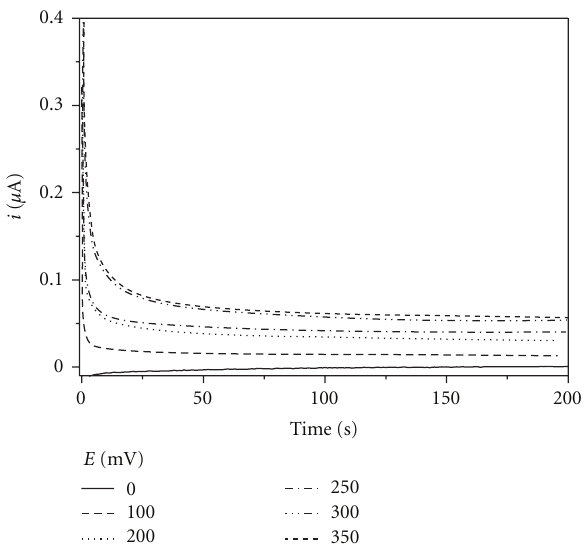
Figure 4: E ff ect of the applied potential on the oxidation of thiocholine in phosphate bu ff er pH 7.4 using 60% (w/w) carbon nanotube paste